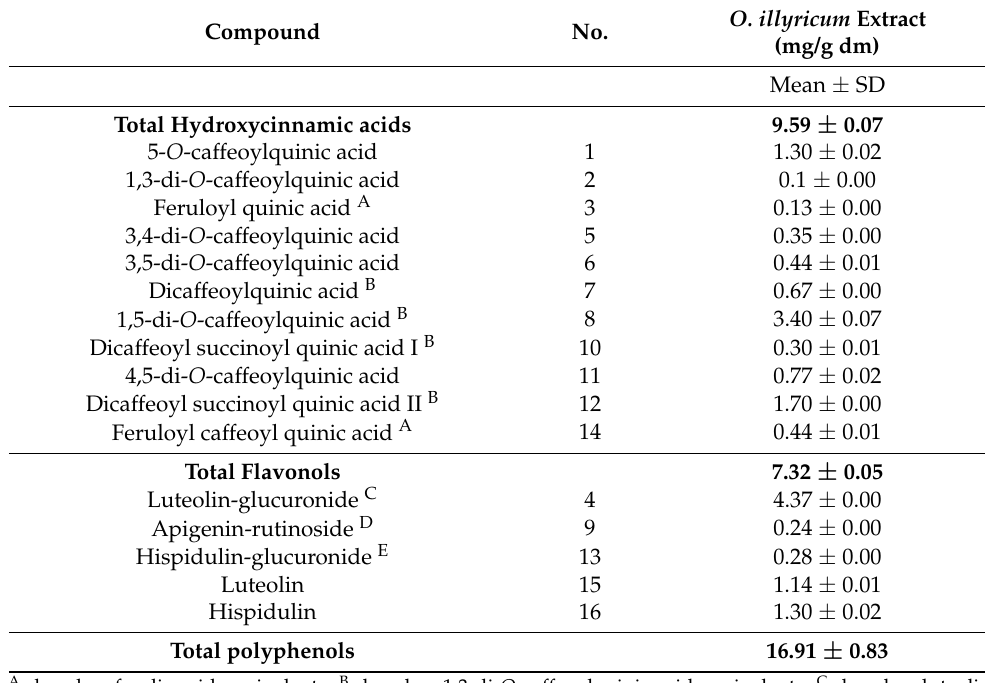
Table 2. Concentration of targeted phenolic compounds detected in O. illyricum extract (mg/g extract dry mass, mean ± SD; n = 3). Compound No.